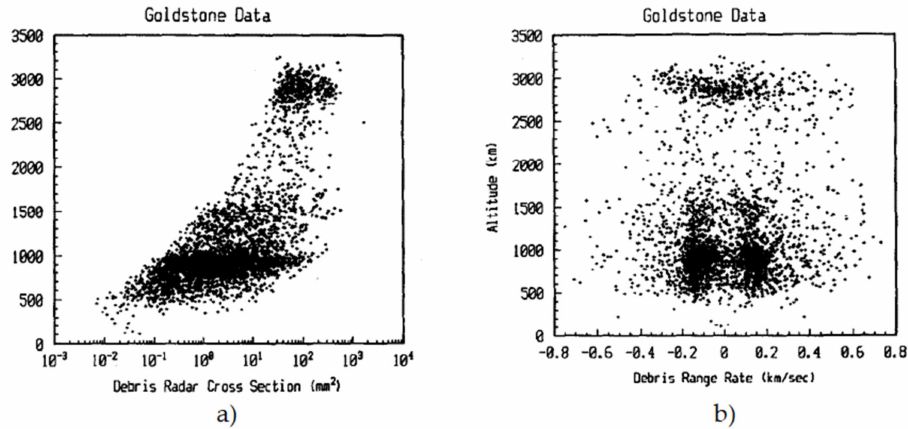
Figure 7. Scatter plot of the objects detected by the Goldstone radar during 1994–1997, showing altitude vs. debris RCS ( a ) and altitude vs. debris range rate ( b ) [21]. Reprinted from Advances in Space Research, Copyright 1999, with permission from